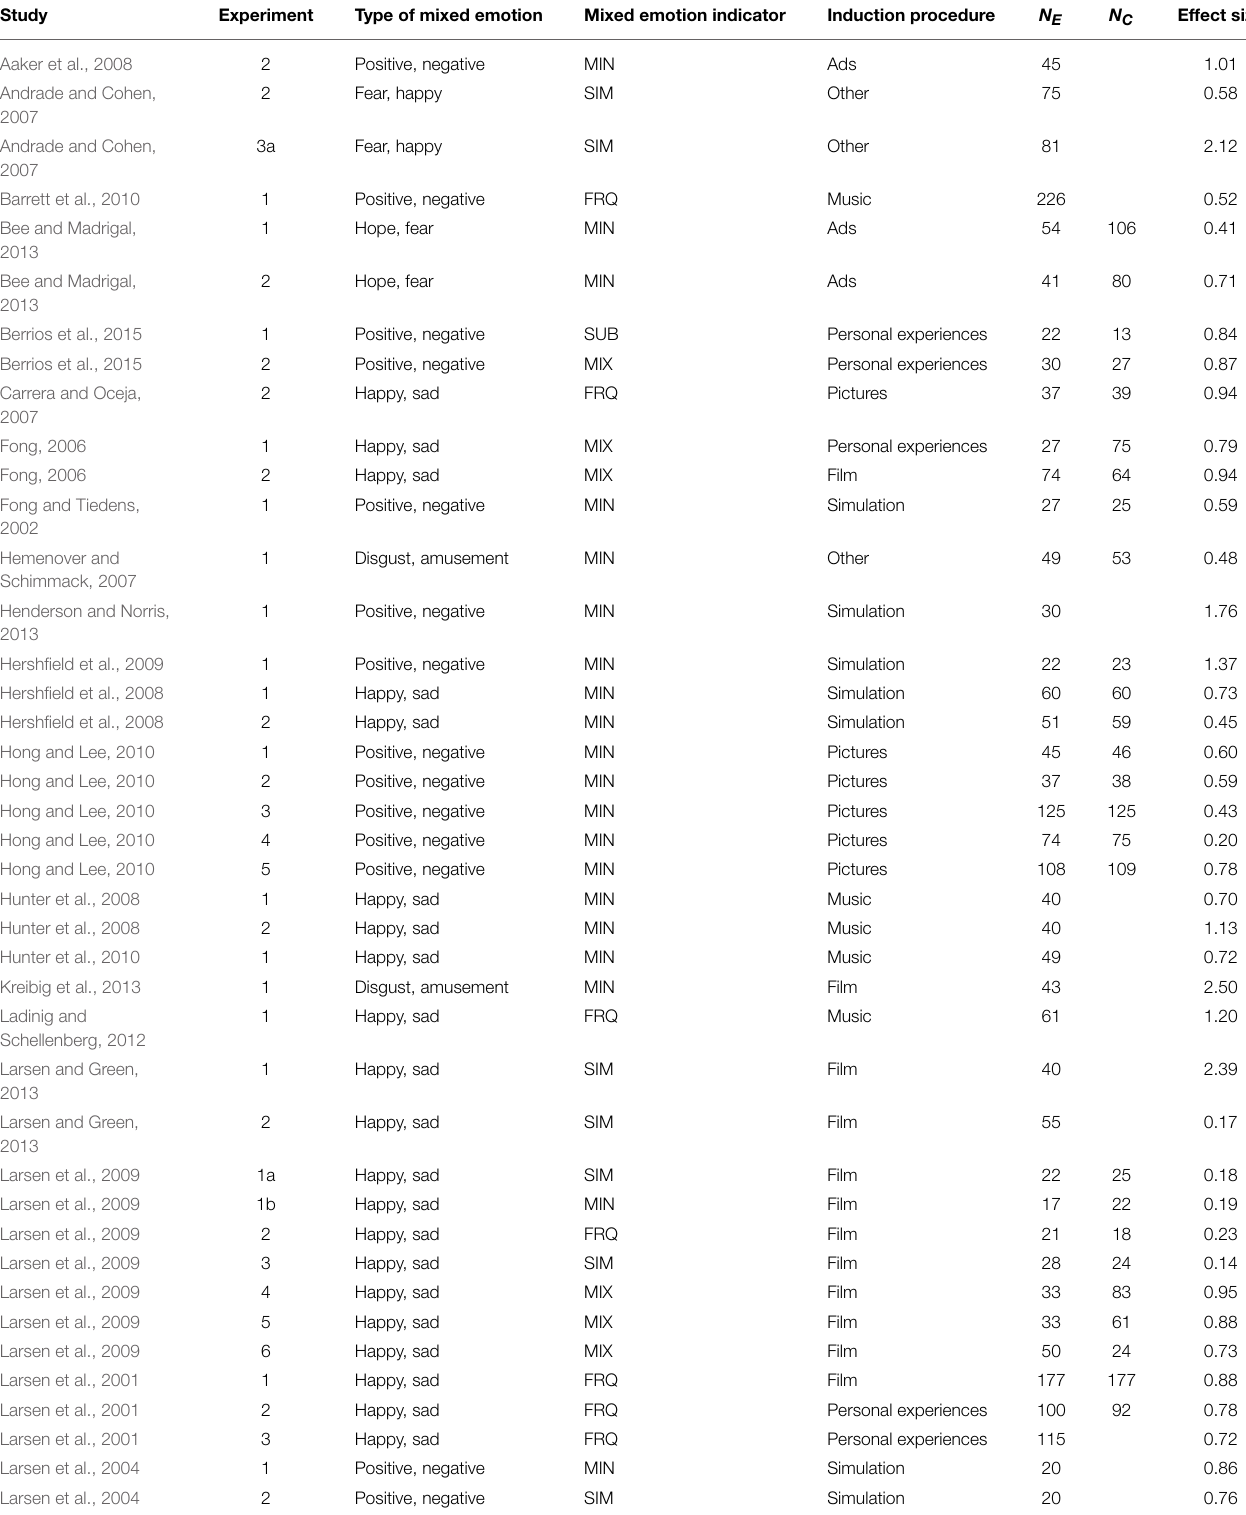
TABLE 1 | Characteristics and effect sizes for studies included in the